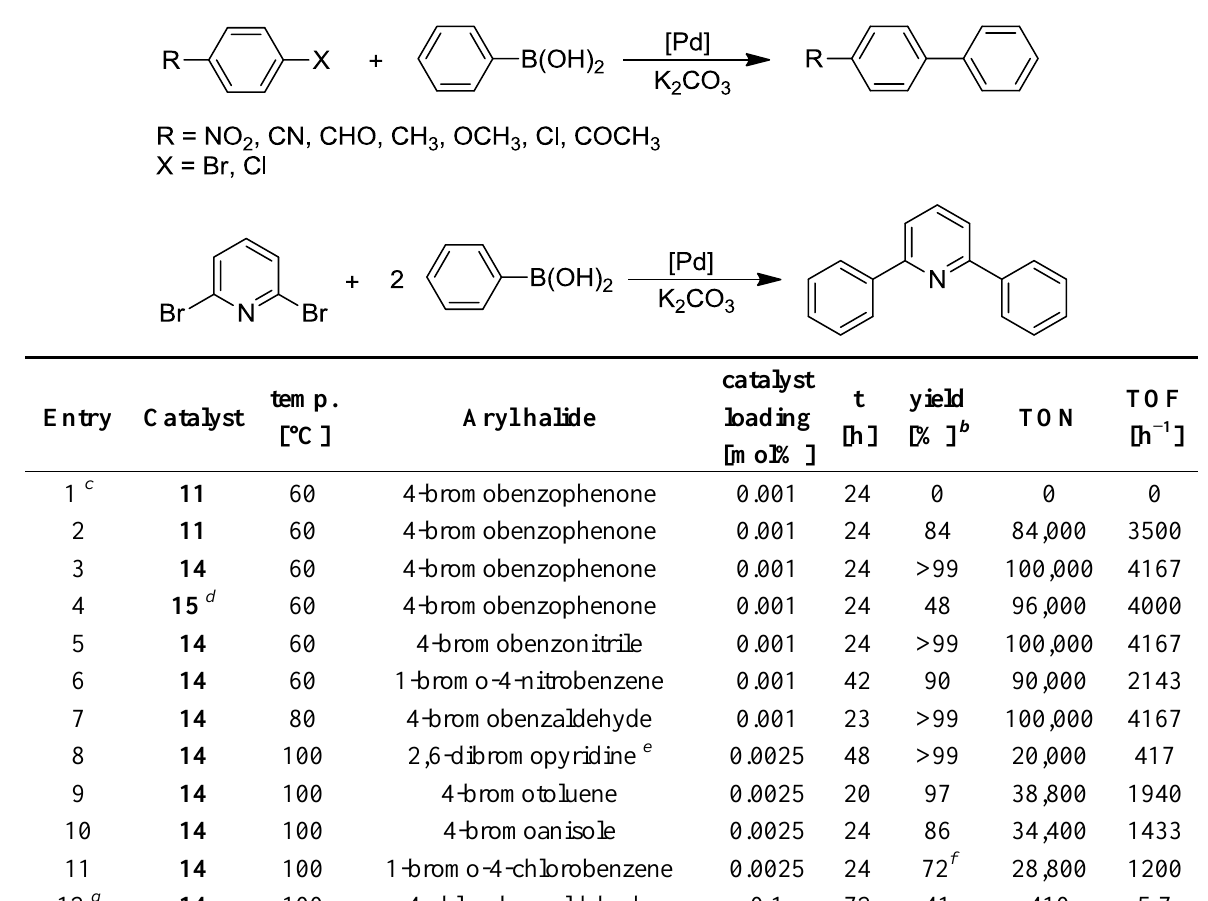
Table 1. Suzuki-Miyaura coupling reactions a catalyzed by complexes 11 , 14 , and 15